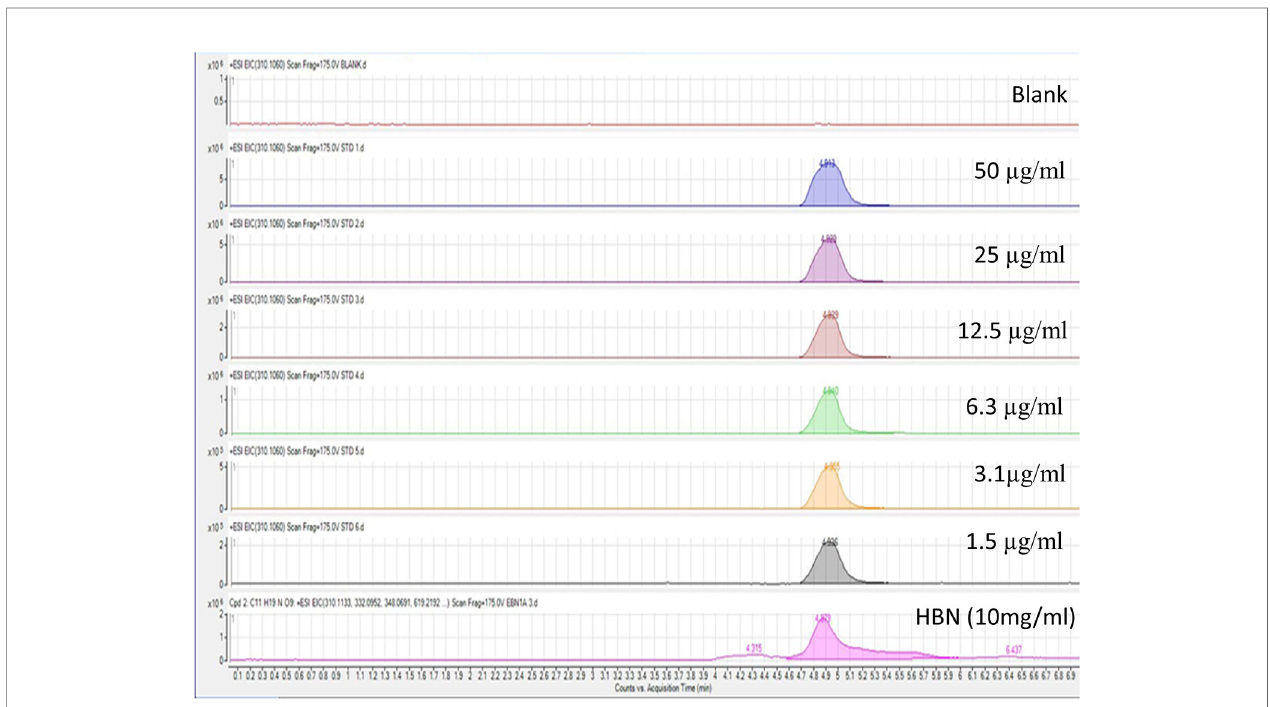
FIGURE 1 | Liquid chromatography-mass spectrometry spectrum of standard sialic acid at different concentrations and 10 mg/mL hydrolyzed bird nest (HBN). HBN contained 1.26 µg sialic acid/mg HBN based on their molecular weight and retention